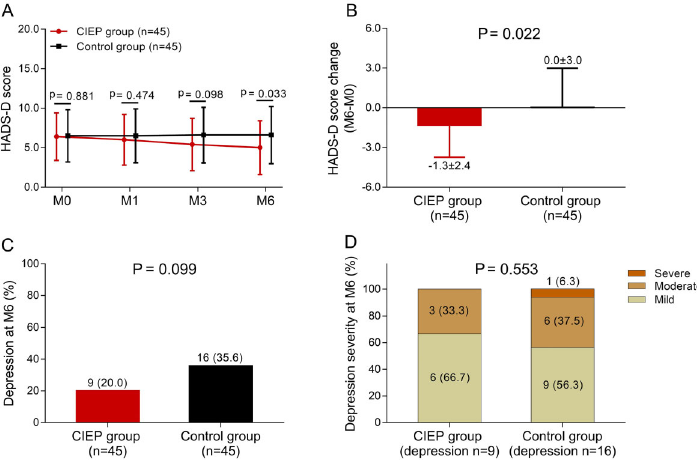
Figure 3. Effect of a caregiver intensive education program (CIEP) on depression in patients with drug-resistant temporal lobe epilepsy and mesial temporal sclerosis (TLE-MTS) who underwent cortico-amygdalohippocampectomy (CAH). A , HADS-D score at month (M)0, M1, M3, and M6 in the CIEP group and control group; B , HADS-D score change (M6-M0) in the two groups. Data are reported as means ± SD. C , Percentage of patients with depression in the two groups and D , percentage of depression severity in the two groups. P o 0.05 was considered statistically signi fi cant by the Student ’ s t -test, Wilcoxon rank sum test, or chi-squared test. HADS-D: Hospital Anxiety and Depression